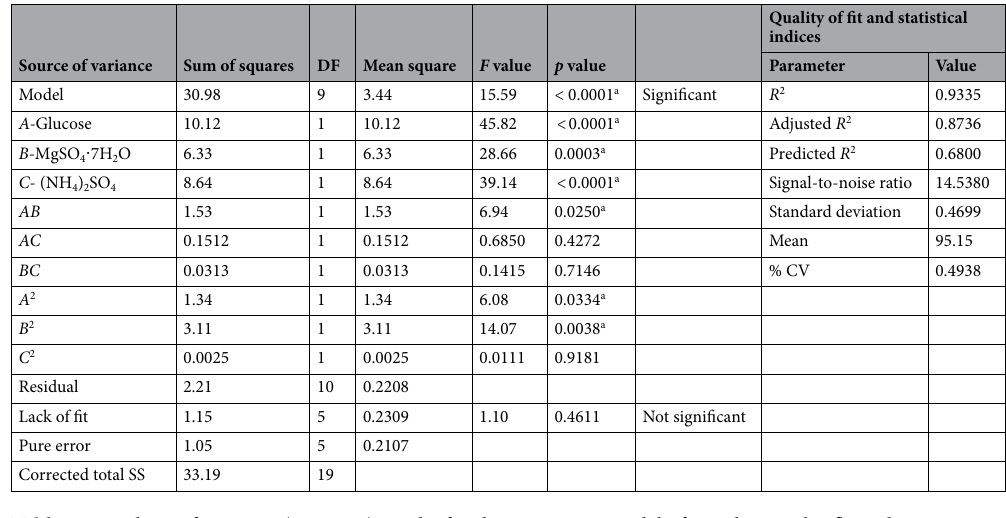
Table 5. Analysis of variance (ANOVA) results for the regression model of B. velezensis bioflocculation activity. DF degree of freedom, CV coefficient of variation. a Statistically significant at the confidence level of